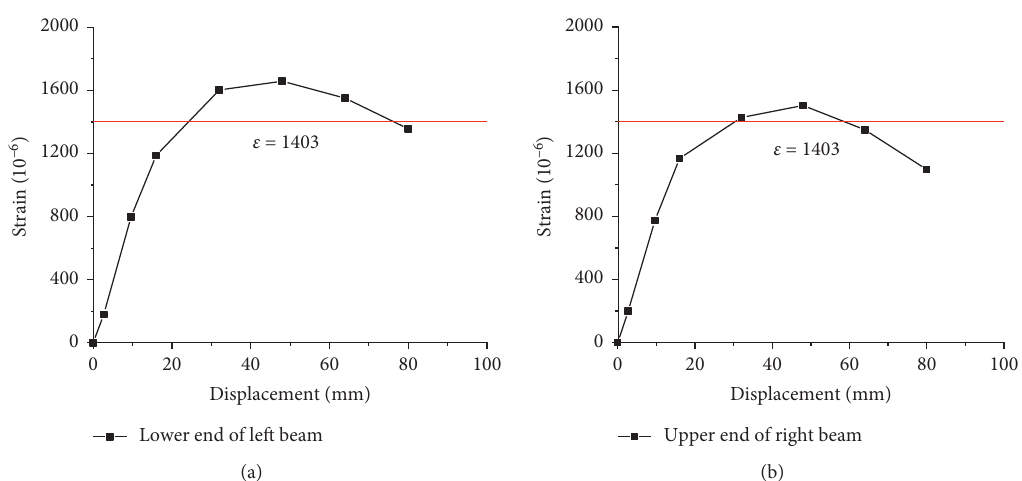
Figure 15: Strain of angle steel of beam end chord ( ε means strain): (a) angle steel of lower end of left beam and (b) angle steel of upper end of right beam.